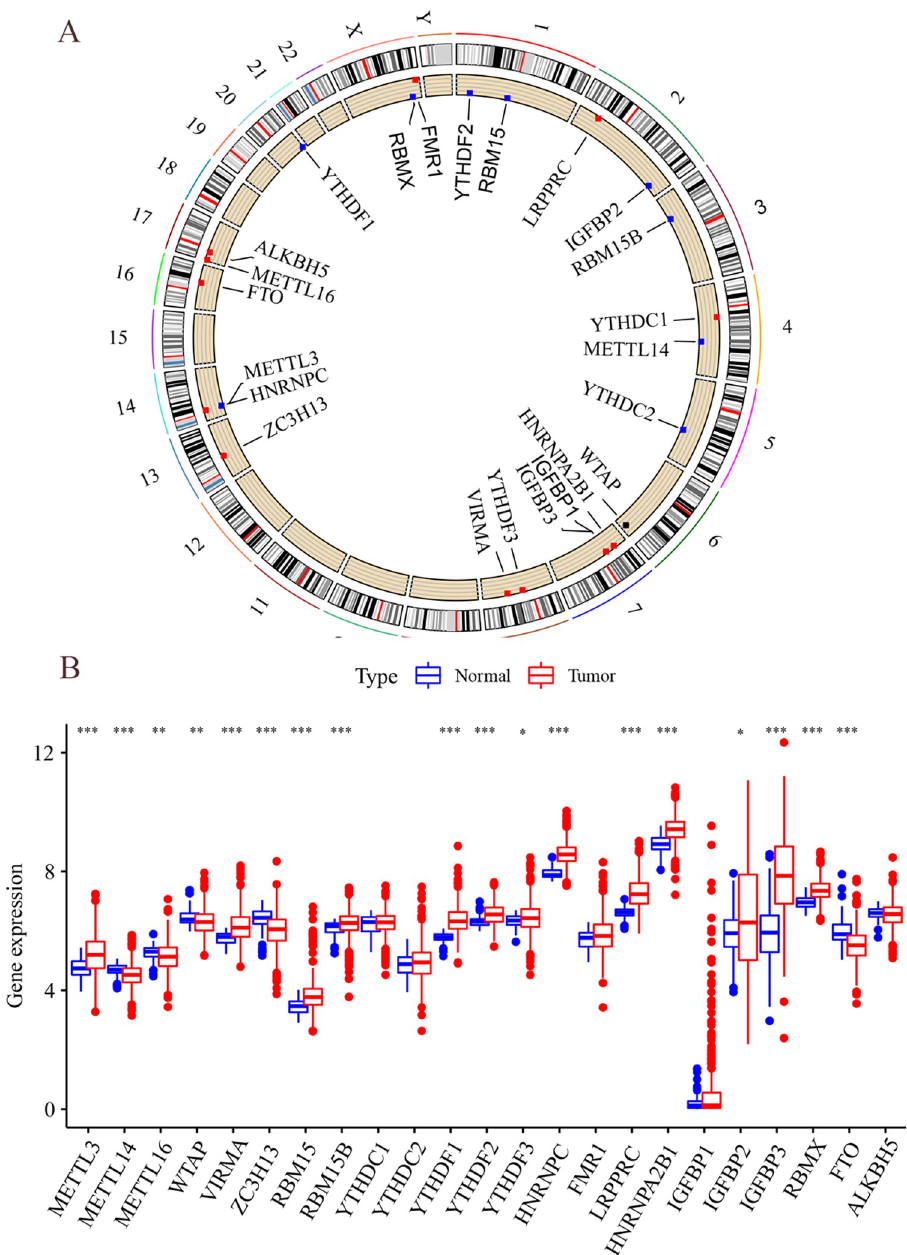
Fig 2. Copy number of m 6 A in chromosomes and analysis of differences. (A) Copy number circle plot. Distribution of m 6 A regulators in 22 pairs of autosomes and 1 pair of sex chromosomes, red circles indicate copy number increase, and blue circles indicate copy number decrease. (B) TCGA-m 6 A differential analysis. Horizontal coordinates indicate m 6 A regulators, vertical coordinates indicate gene expression, � P < 0.05, � � P < 0.01, and � � � P < 0.001.